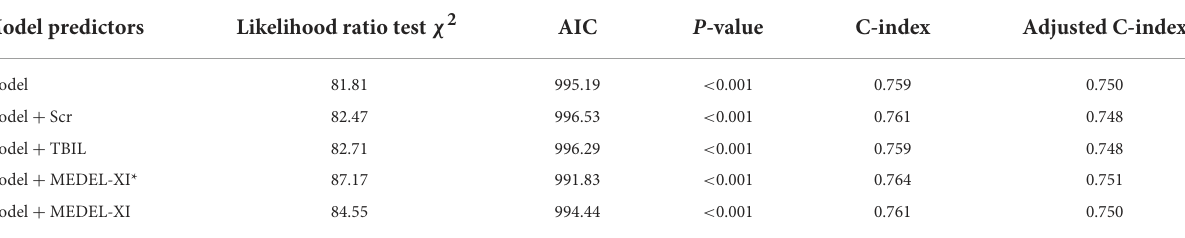
TABLE 3 Comparison of different prognostic models on CHF